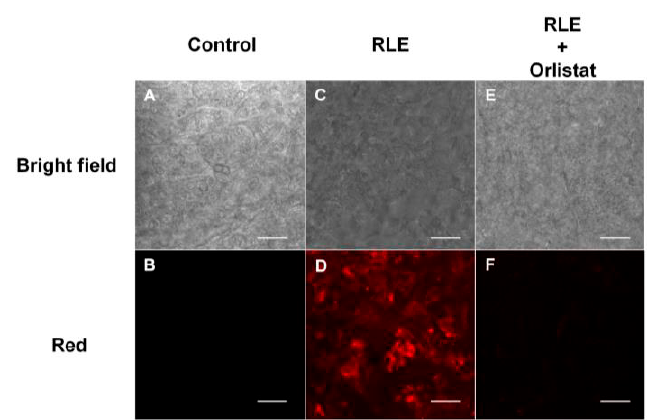
Figure 5. Confocal images of monkey pancreas slices. ( A , B ) Slices incubated with PBS only for 30 min. ( C , D ) Slices incubated with RLE (15 µM) for 20 min. ( E , F ) Slices incubated with RLE (15 µM) after treatment with orlistat (25 µM) for 15 min. Red channel for RLE: λ ex = 552 nm, λ em = 580 − 600 nm. Scale bars = 25 µm.